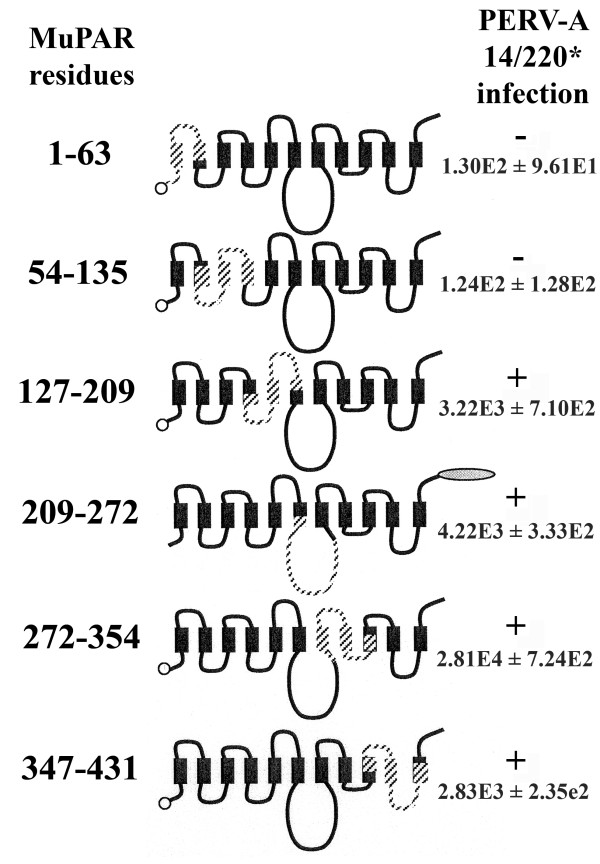
MuPAR and HuPAR2 chimeras reveal regions required for PERV-A 14/220* infection. MuPAR is not permissive for PERV-A binding and entry, while HuPAR2 is permissive for both. Chimeras were constructed by swapping regions of HuPAR2 (solid black) with the corresponding residues of MuPAR (hatched black). Constructs were tagged with either an N-terminal c-myc tag (open circle) or a C-terminal eGFP tag (gray oval), as a way to monitor expression. Chimeras were expressed in non-permissive SIRC cells and tested for PERV-A infection. Levels of infection were determined by PERV pol qPCR of 250 ng genomic DNA and compared to wild-type HuPAR2 and MuPAR. (-/+) indicates the status of PERV-A infection. The average PERV pol copy numbers and standard deviations (n = 3) are shown for each. These chimeras revealed that the N-terminal 135 amino acids are critical for PERV-A 14/220* infection.